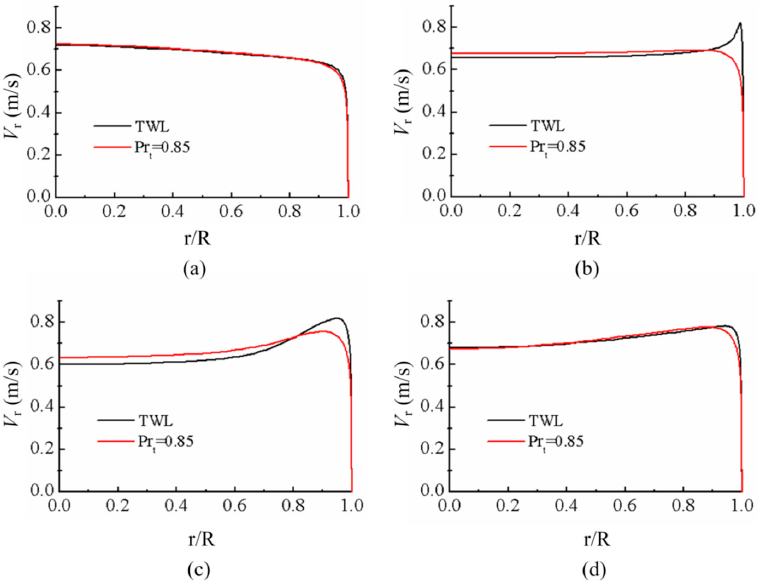
Figure 7. Distribution of the axial velocity in different sections: ( a ) x/D = 13; ( b ) x/D = 26; ( c ) x/D = 39; and ( d ) x/D =